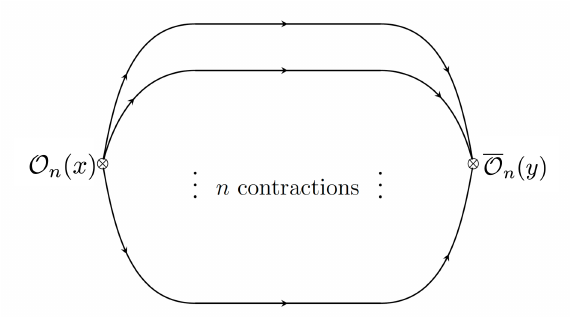
Figure 2 . When the contractions are made with free propagators one obtaines the tree-level result G (0) n at the leading order for N → ∞ is given by